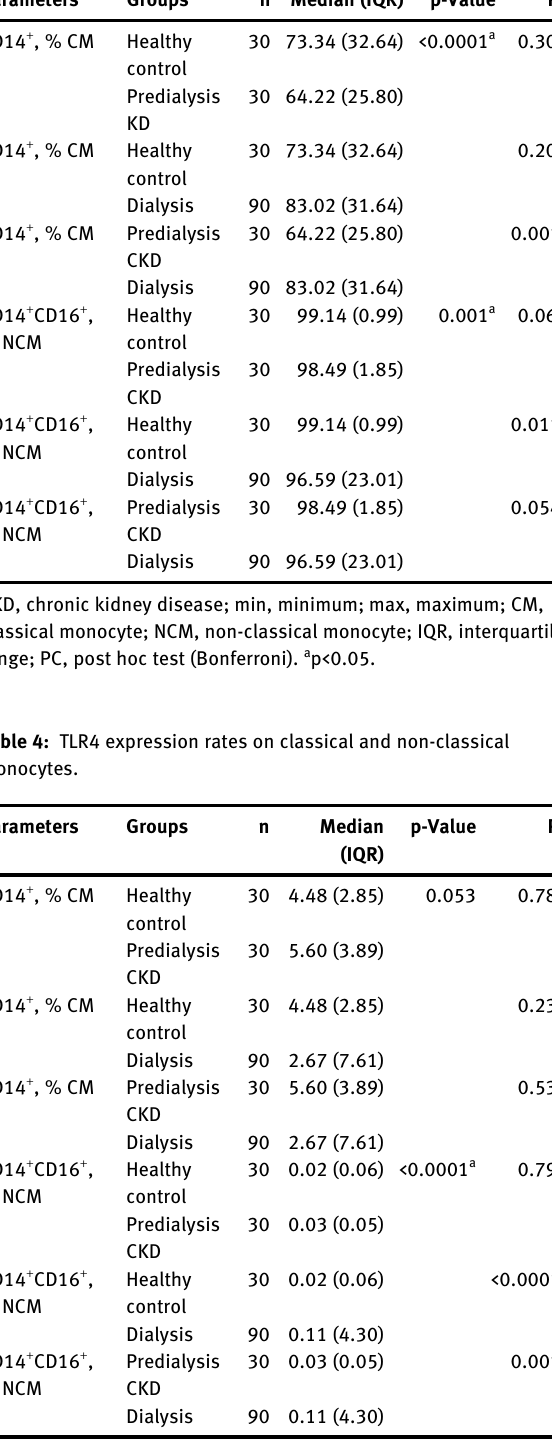
Table  : TLR  expression rates on classical and non-classical monocytes.